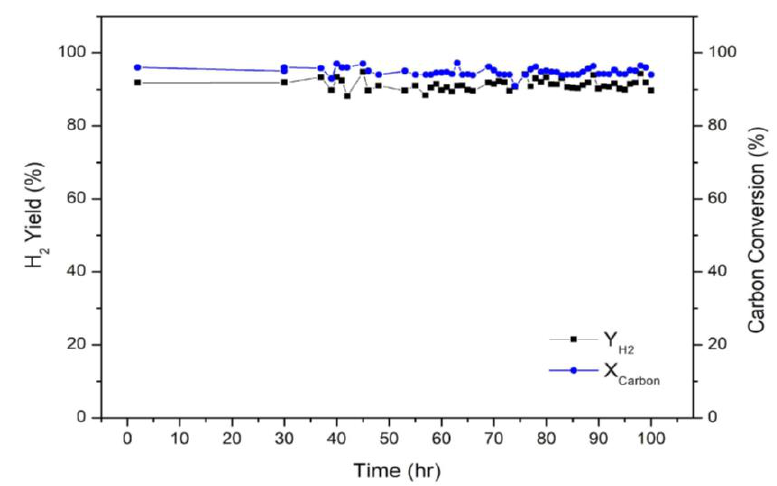
Figure 11. The durability and activity test of the catalyst for 100 h. (temp.= 850 °C , S/C = 2, GHSV = 10,000h -1 ).